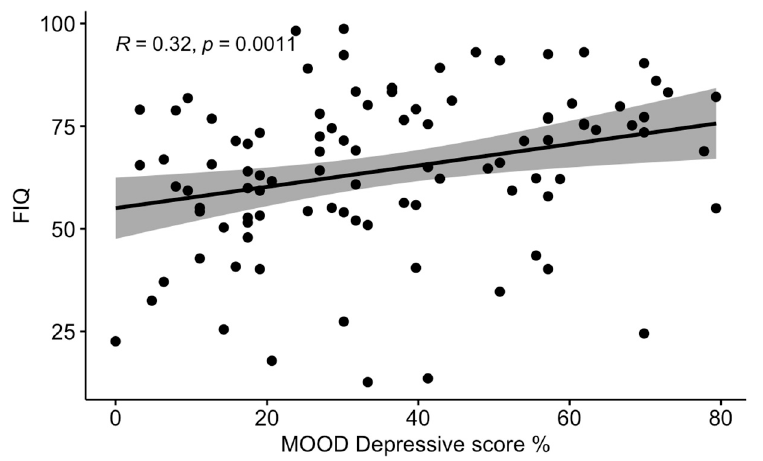
Figure 1. Correlation between the MOOD—depressive domain (percentage values) and the FIQ score.